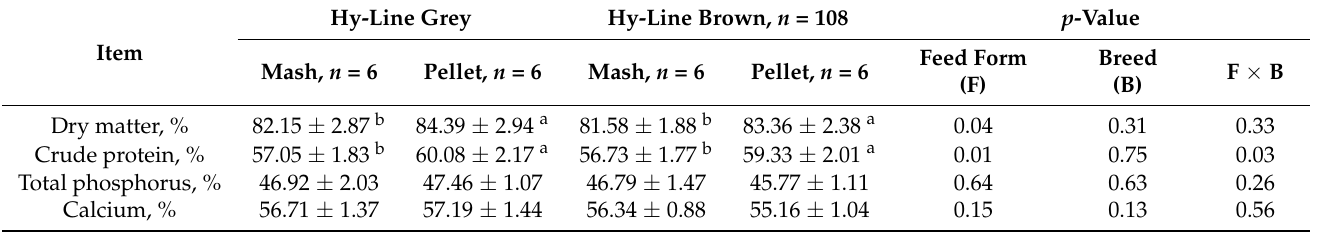
Table 6. Effects of feed form on the apparent digestibility of nutrients of layers.